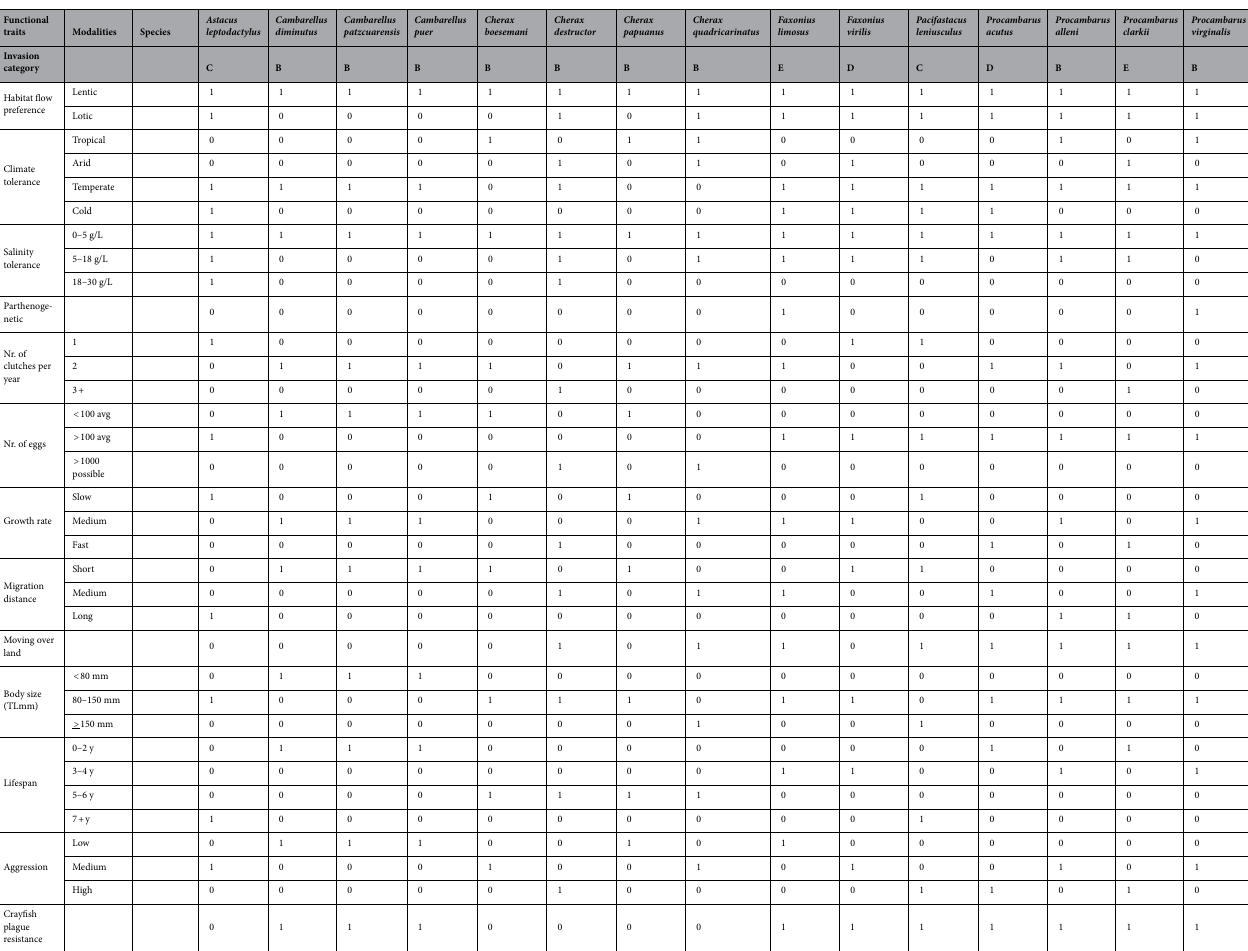
Table 2. Functional traits and invasion category of 15 crayfish species present in the Netherlands in the wild or in aquaria. Literature sources for trait values can be found in Supplementary Tables S2 and S3 of the supplementary materials.